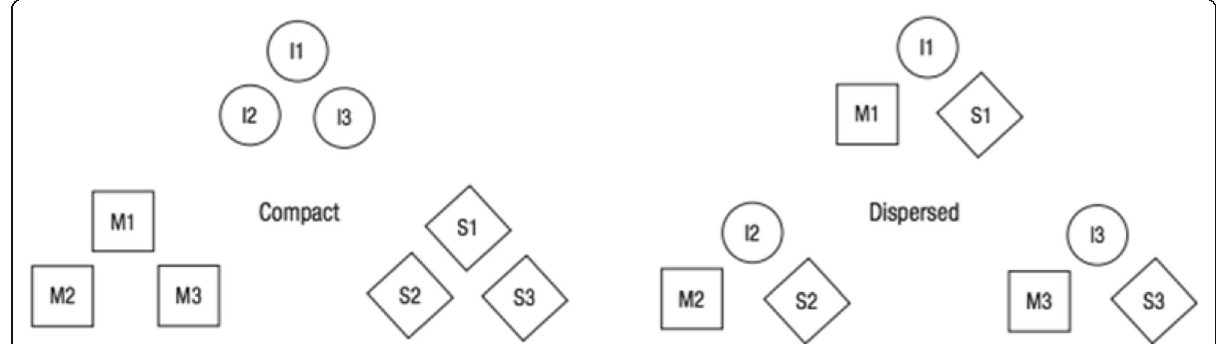
Fig. 1 A schematic illustration of the compact and dispersed category structures tested in Nosofsky et al. ’ s (2017) study. Circles indicate igneous, squares indicate metamorphic, and diamonds indicate sedimentary